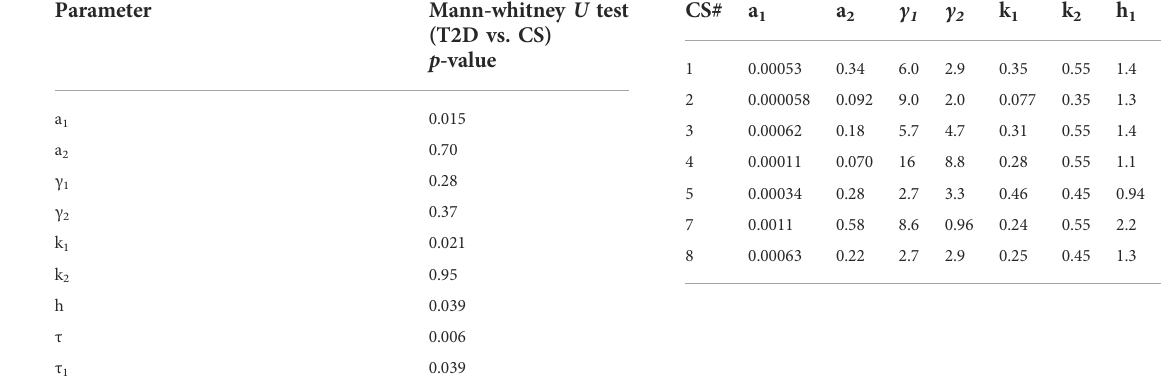
TABLE 4 Results of the Mann-Whitney U test. The insulin sensitivity parameter, a 1 , the glucagon suppression parameter k 1 , the Hill coef fi cient h, the insulin secretion time delay τ 1 and the infused glucose R IIGI time delay τ , are found to be signi fi cantly different between the T2D and CS